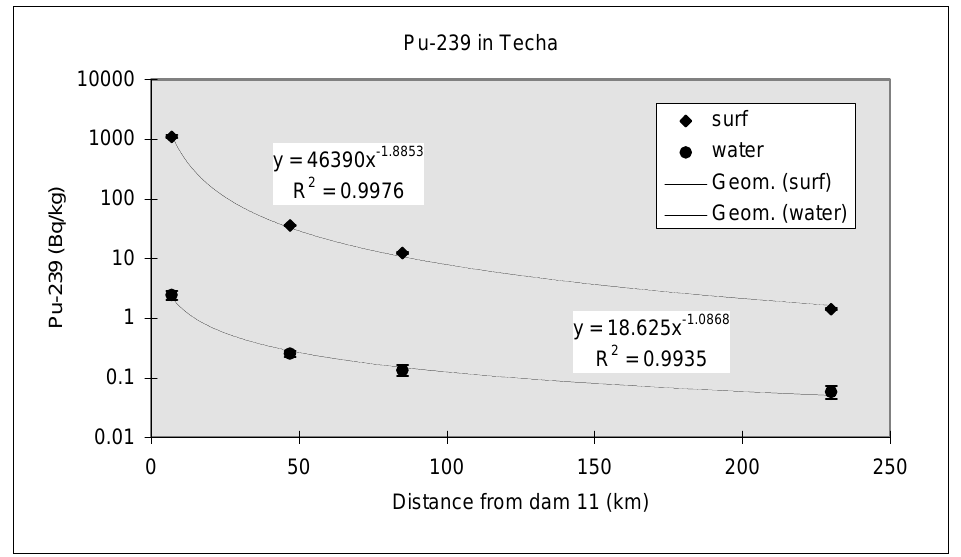
FIGURE 3 . 239 Pu a c tivity concentrations in surface sediments (Bq/kg) and filtered waters (Bq/l) in the Techa, Iset, and Ob Rivers[30].